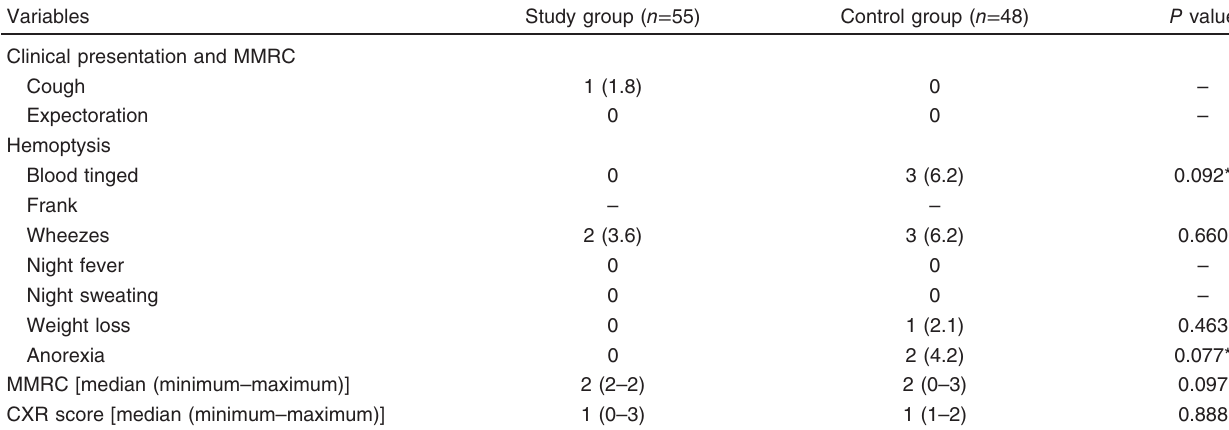
Table 2 Follow-up characteristics of both groups ’ clinical presentation and radiology Variables